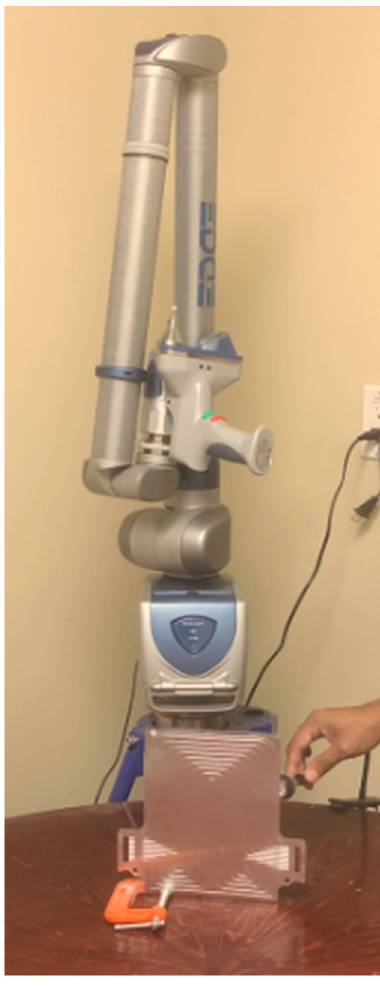
Figure 2. Laser scanning set-up.